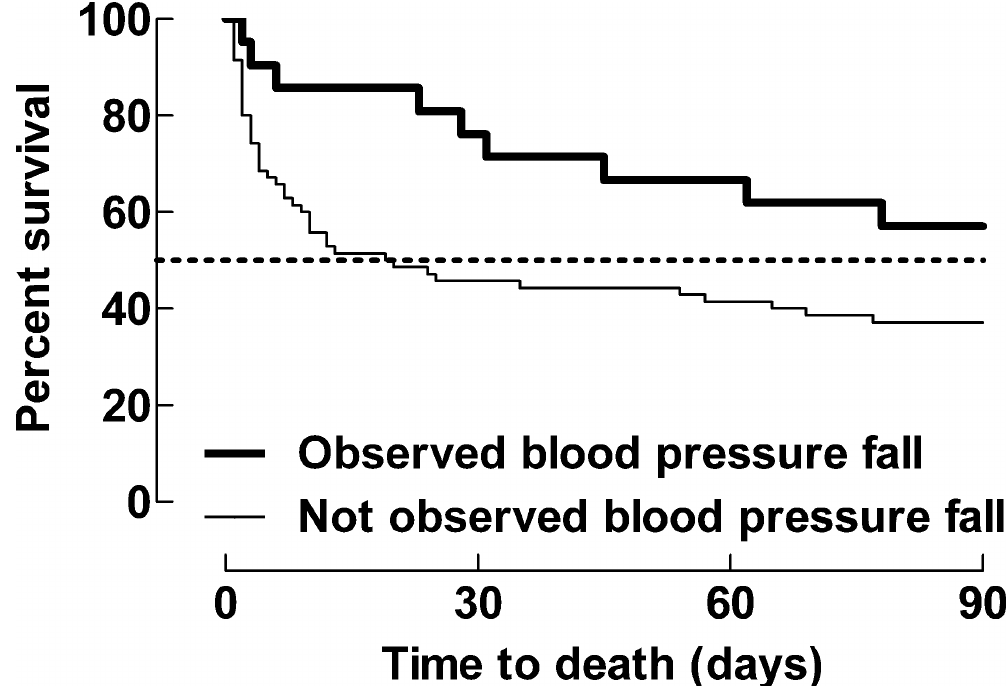
Fig 5. Kaplan-Meier curve comparing patient mortality with point of time was known or unknown for a blood pressurefall below MAP 65 mmHg. p = 0.0291(Gehan-Breslow-Wilcoxon Test).